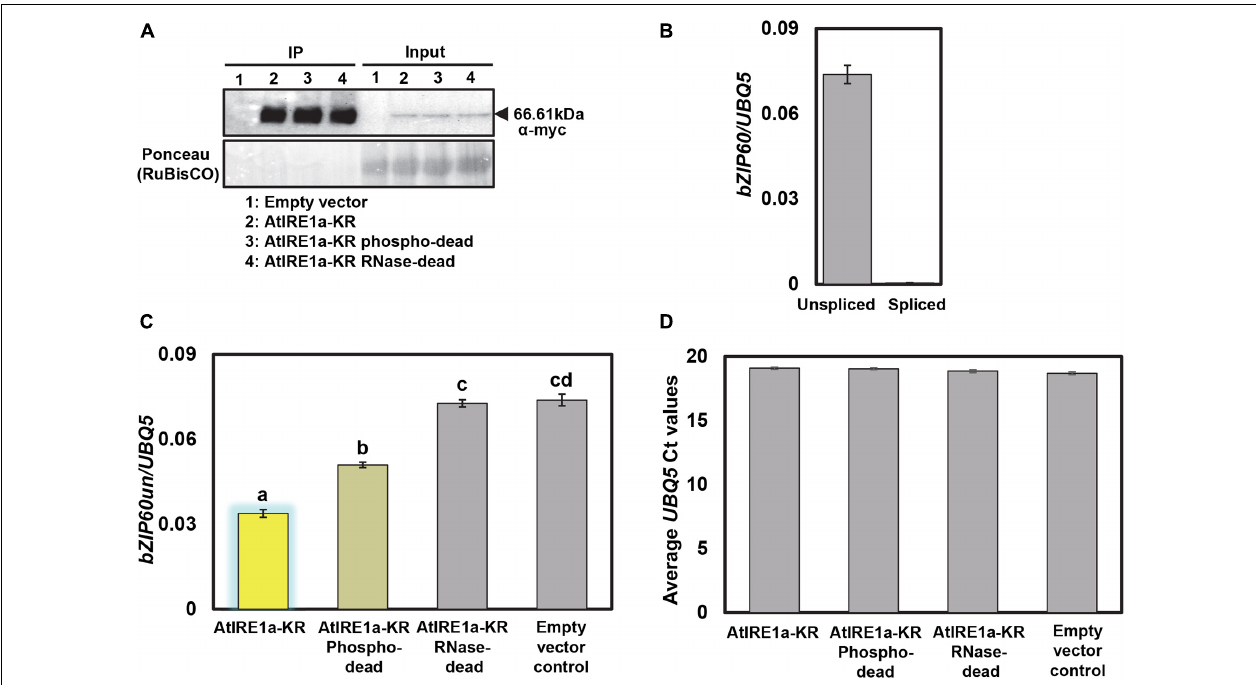
FIGURE 3 | Protein expression levels of N. benthamiana expressed AtIRE1a-KR variants and their effects on AtbZIP60 mRNA cleavage. (A) 10myc-tagged AtIRE1a-KR, AtIRE1a-KR phospho-dead, and AtIRE1a-KR RNase-dead proteins expressed in N. benthamiana were subjected to immunoprecipitation. A Western blot probed with an anti-myc antibody was used to detect the presence of protein. Ponceau staining in the input fraction indicates equal amounts of proteins expressed; (B) Bar graphs representing bZIP60us (unspliced bZIP60) and bZIP60s (spliced bZIP60) mRNA levels before performing the in vitro mRNA cleavage assay; (C) Bar graph representing bZIP60us mRNA levels after performing the in vitro mRNA cleavage assay. The measured mRNA expression levels were normalized to an Arabidopsis housekeeping gene UBQ5 ( Ubiquitin 5 ). The colors of the bars correspond to the RNase status as indicated above ( Figure 2D ). Statistical analysis was performed using an online interface (https://astatsa.com) by one-way ANOVA with post-hoc Tukey HSD test calculator. Error bars show mean ± SD. Bars labeled by different letters differed from each other at p < 0.05; (D) The levels of UBQ5 transcripts in various samples were monitored to control for mRNA degradation. Error bars show mean ± SD and differences were not statistically significant. All experiments were performed at least three times, each with three independent technical